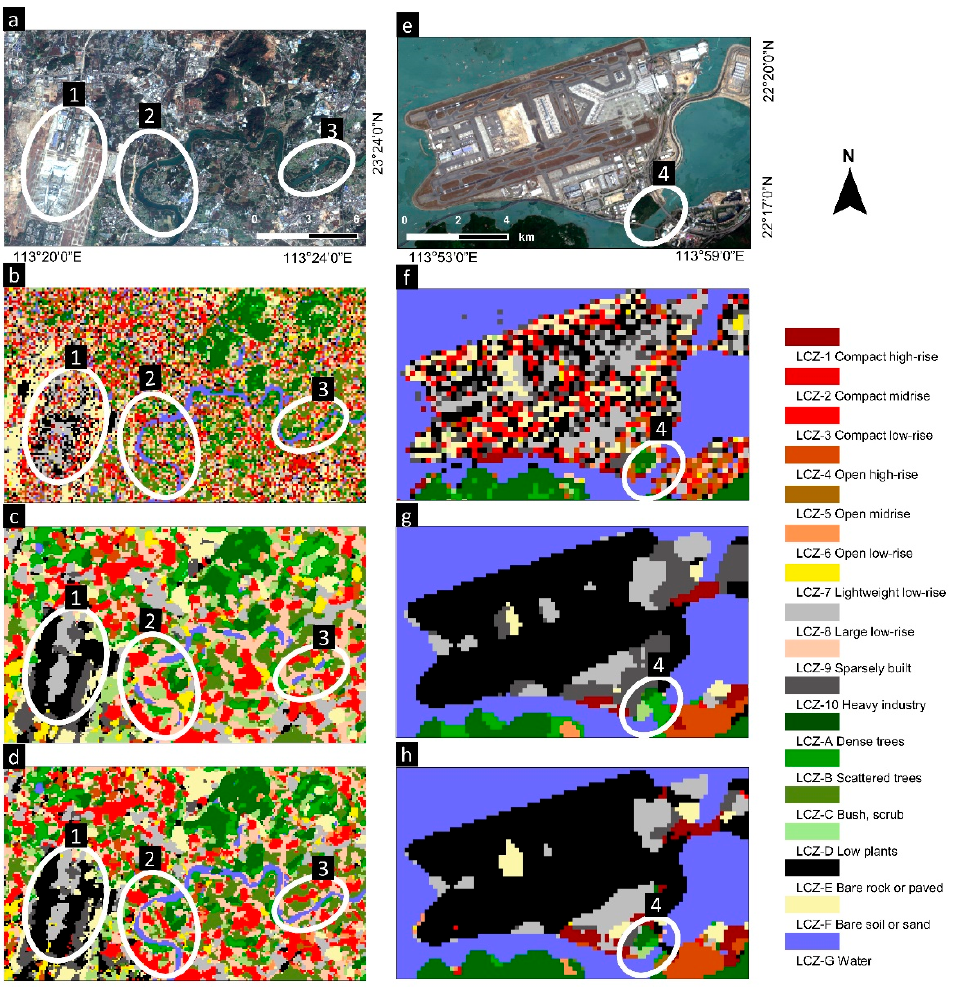
Figure 6. The partial results of three methods. ( a – d ) The LCZ maps around the Guangzhou Baiyun Airport: ( a ) original image, ( b ) Random Forest result, ( c ) ResNet result, and ( d ) SVS result. ( e – h ) LCZ maps of the Hongkong international Airport: ( e ) original image, ( f ) Random Forest result, ( g ) ResNet result, and ( h ) SVS result.